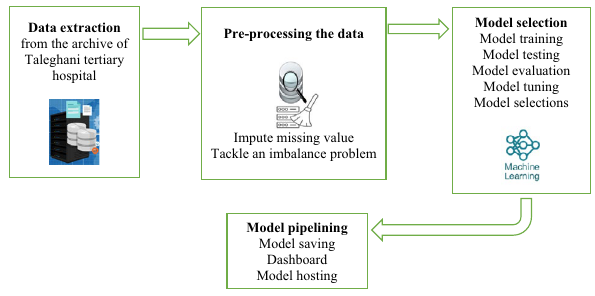
Figure 1. Framework of